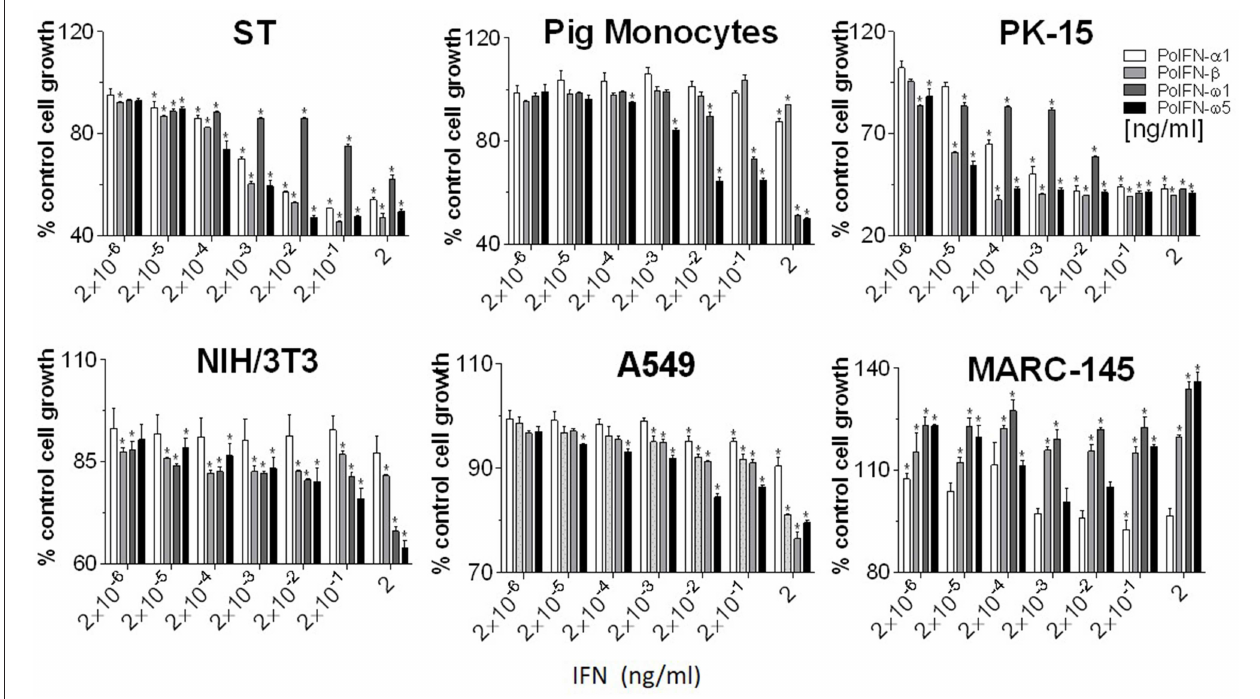
FIGURE 6 | Interferon antiproliferative activity assay. Cellular viability was assessed by trypan blue dye exclusion (23, 24). Five-hundred cells in 100 µ l volume were added to each well of a flat-bottom 96-well plate in triplicate. Cells were treated with or without IFN peptides at indicated concentrations and incubated at 37 ◦ C for 72h. Cell growth was determined by a MTS-salt assay (Promega, Madison, WI). Briefly, 20 µ l of MTS reagent was added to each well and the plate incubated for 2–4h at 37 ◦ C. Following color development, absorbance was measured at 490nm on a with a SpectraMax i3 (Molecular Devices) spectrometer. Data, mean ± SE, n = 6, * p < 0.05 compared to the mock-treated control.